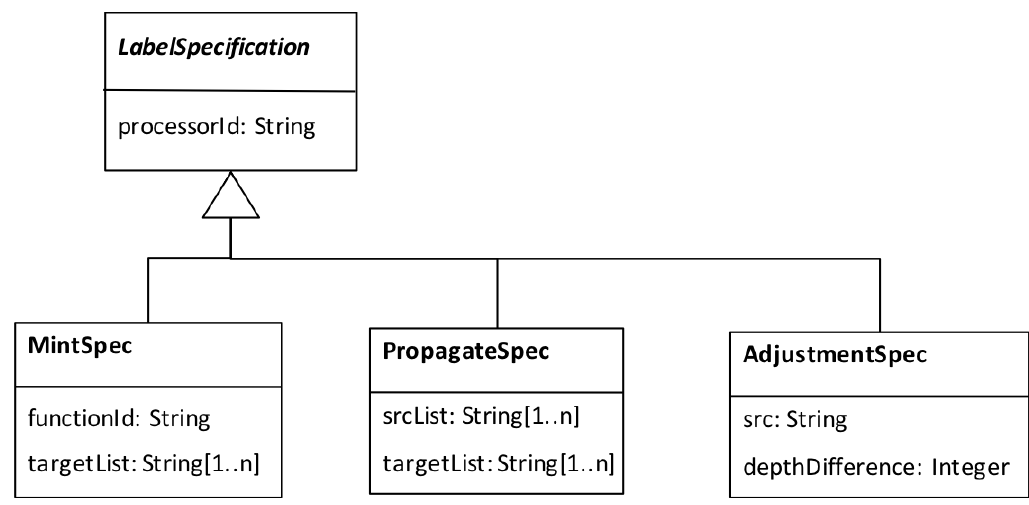
Figure 12. UML Class Diagram denoting information model of Labelling